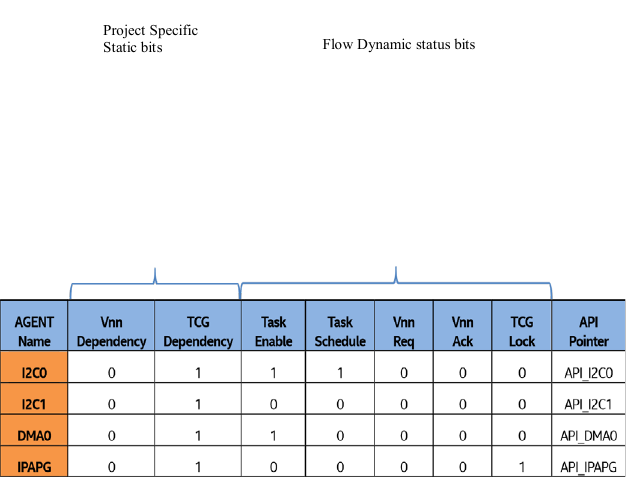
Fig. 3. Dashboard Structure with Controller flows Each column of the DB together gives the status of any flow corresponding to each row and consists of static (project specific) and dynamic (run time) bits. The DB is initialized once, setting project specific bits with appropriate values and dynamic bits with default